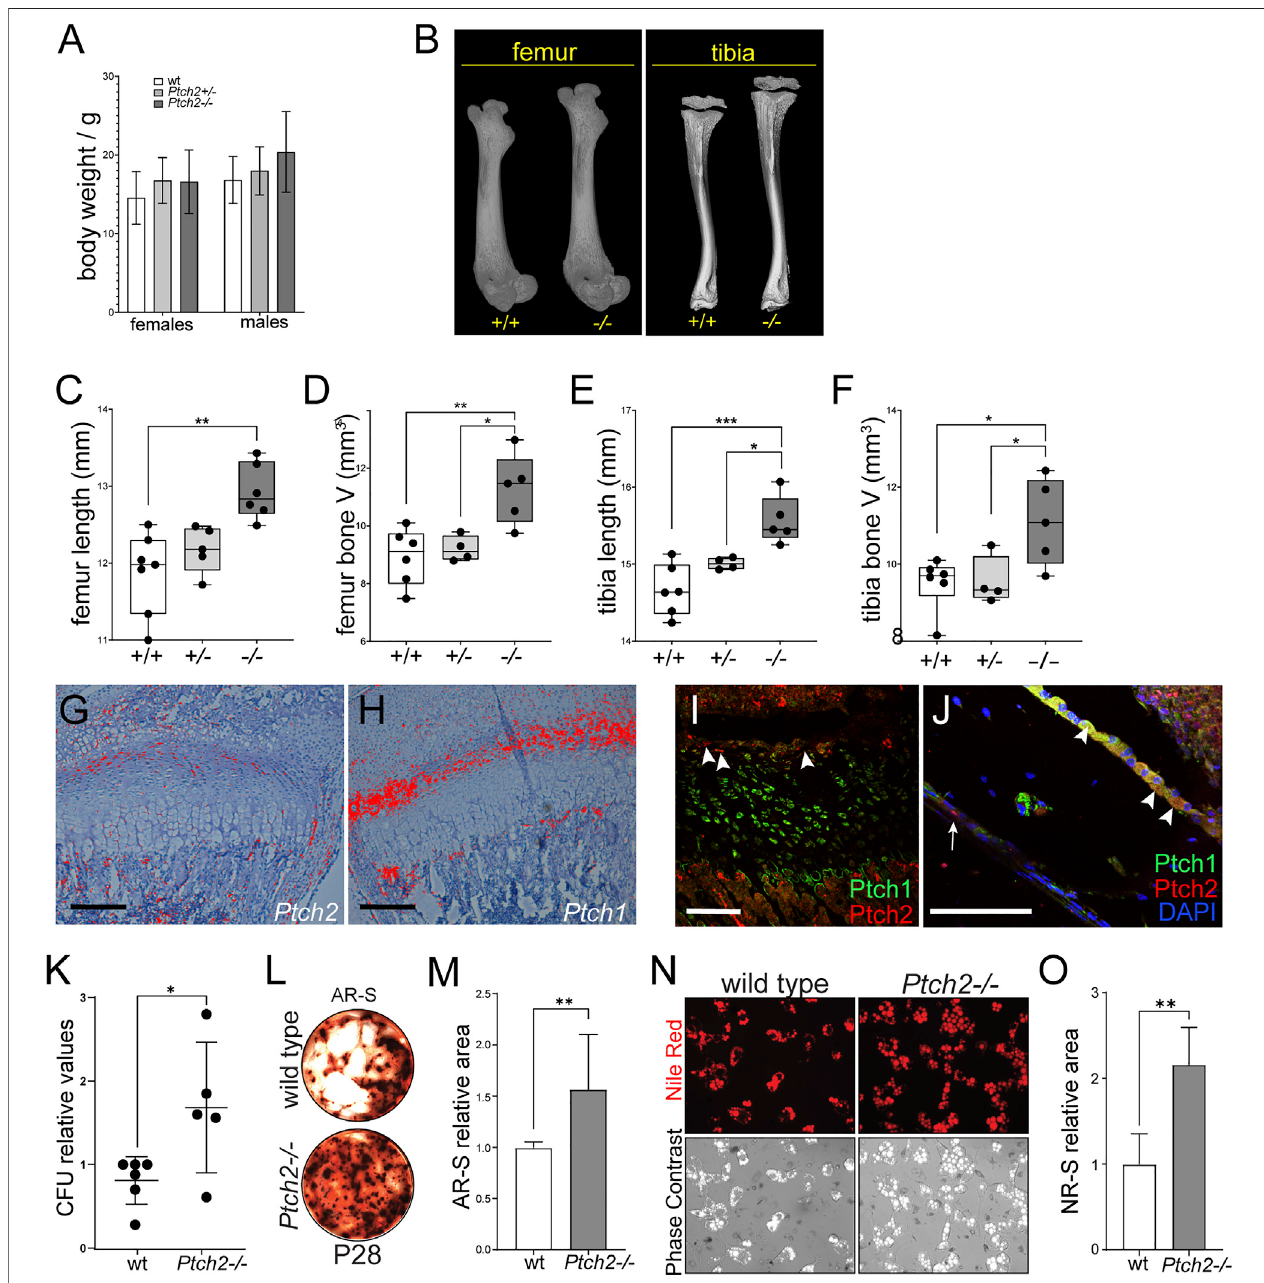
FIGURE 2 | Loss of Ptch2 affects bone size and SC potential. (A) Body weight of P28-35 wild-type, Ptch2 +/ − , and Ptch2 − / − mice . (B – F) Quanti fi cationof μ CT analysis of P28-33 femora and tibiae isolated from wild-type, Ptch2 +/ − , and Ptch2 − / − littermates. (G,H) Radioactive in situ hybridization in 2-week-old tibiae detecting Ptch2 (G) and Ptch1 (F) . (I,J) Immunostaining for Ptch1 (green) and Ptch2 (red) in the growth plate (I) and cortical bone (J) of 4-week-old tibiae. Arrowheads indicate Ptch2 + cells in the resting zone of the growth plate (I) and endosteum (J) . Arrow in (J) indicates Ptch2 + cells in the periosteum layer. (K – O) Analysis of the mineralization (K – M) andadipogenic (N,O) differentiationpotentialofbonemarrowstromalstemcells.AlizarinRedStaining (L) ofterminatedculturesatday21ofculture and Nile Red imaging (N) of live adipocytes in 14-day-old cultures of bone marrow stromal stem cells isolated from 8-week-old animals. P-values: * p ≤ 0.05, ** p ≤ 0.01, *** p ≤ 0.001. Scale bars 100 μ